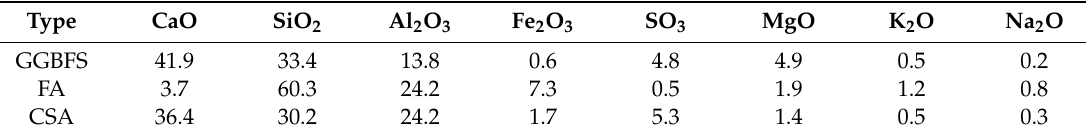
Table 1. Chemical composition of ground granulated blast furnace slag (GGBFS), fly ash (FA), and calcium sulfoaluminate-based (CSA) expansion agent.